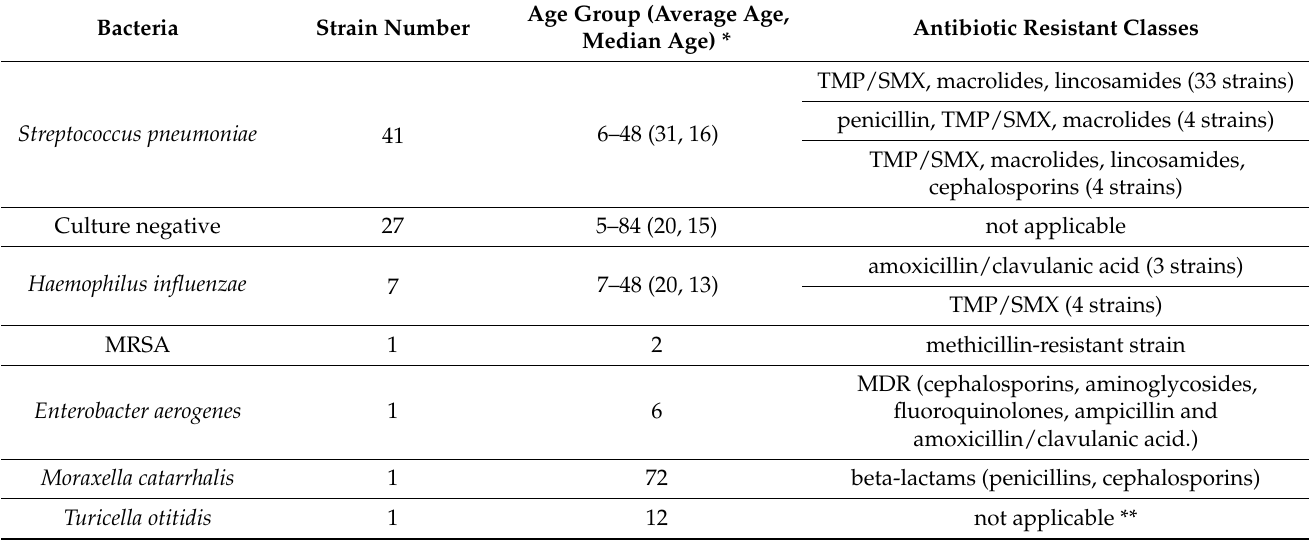
Table 5. Microbiological profile in treatment failure